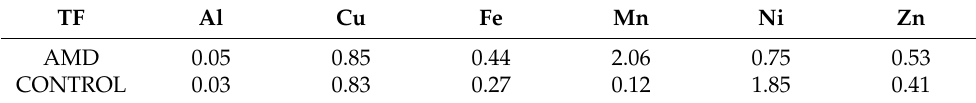
Table 2. Translocation factor (root/shoot) of AMD and control grown vetiver. TF Al Cu Fe Mn Ni Zn AMD 0.05 0.85 0.44 2.06 0.75 0.53 CONTROL 0.03 0.83 0.27 0.12 1.85